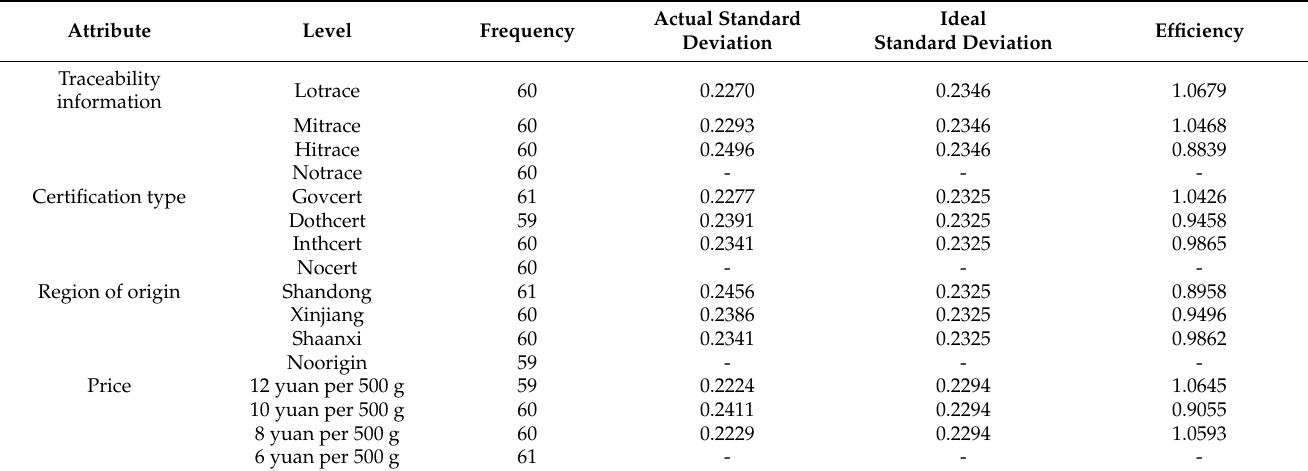
Table A1. A priori estimates of standard errors for attribute levels.